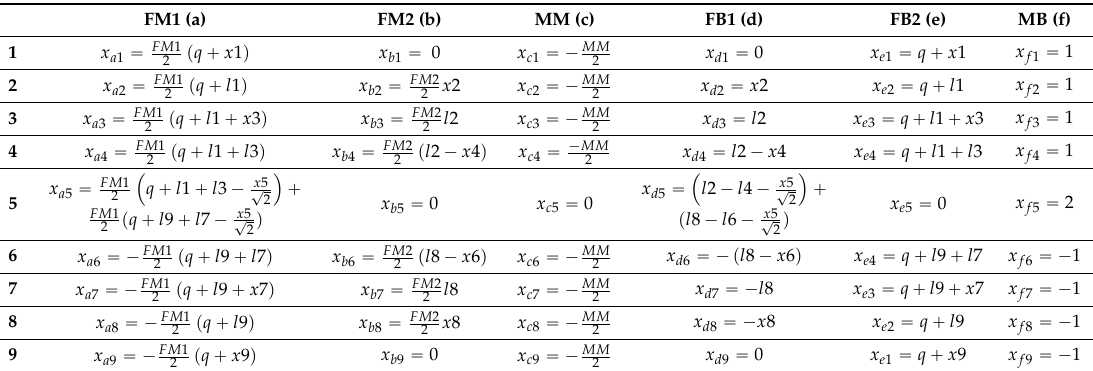
Figure 5. The bending moment diagram of the circle resonator simplified mechanics model after removing the constraints at the lumped masses symmetric axes. ( a ) Simulating external forces under the anti-phase drive mode; ( b ) Simulating external forces under the anti-phase sense mode; ( c ) Simulating external forces under lumped mass twisting motion coupling with anti-phase sense mode; ( d ) Assuming internal forces along the tangential orientation; ( e ) Assuming internal forces along the radial of the symmetric center; ( f ) Assuming internal forces along the lumped mass twisting motion. Table 1. Torque expressions of x ak ~ x fk .